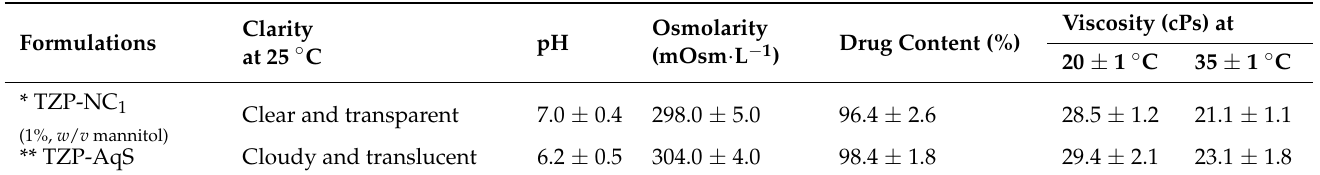
Table 4. Physicochemical characterization of redispersed NC 1 and conventional TZP-AqS (mean ± SD, n =